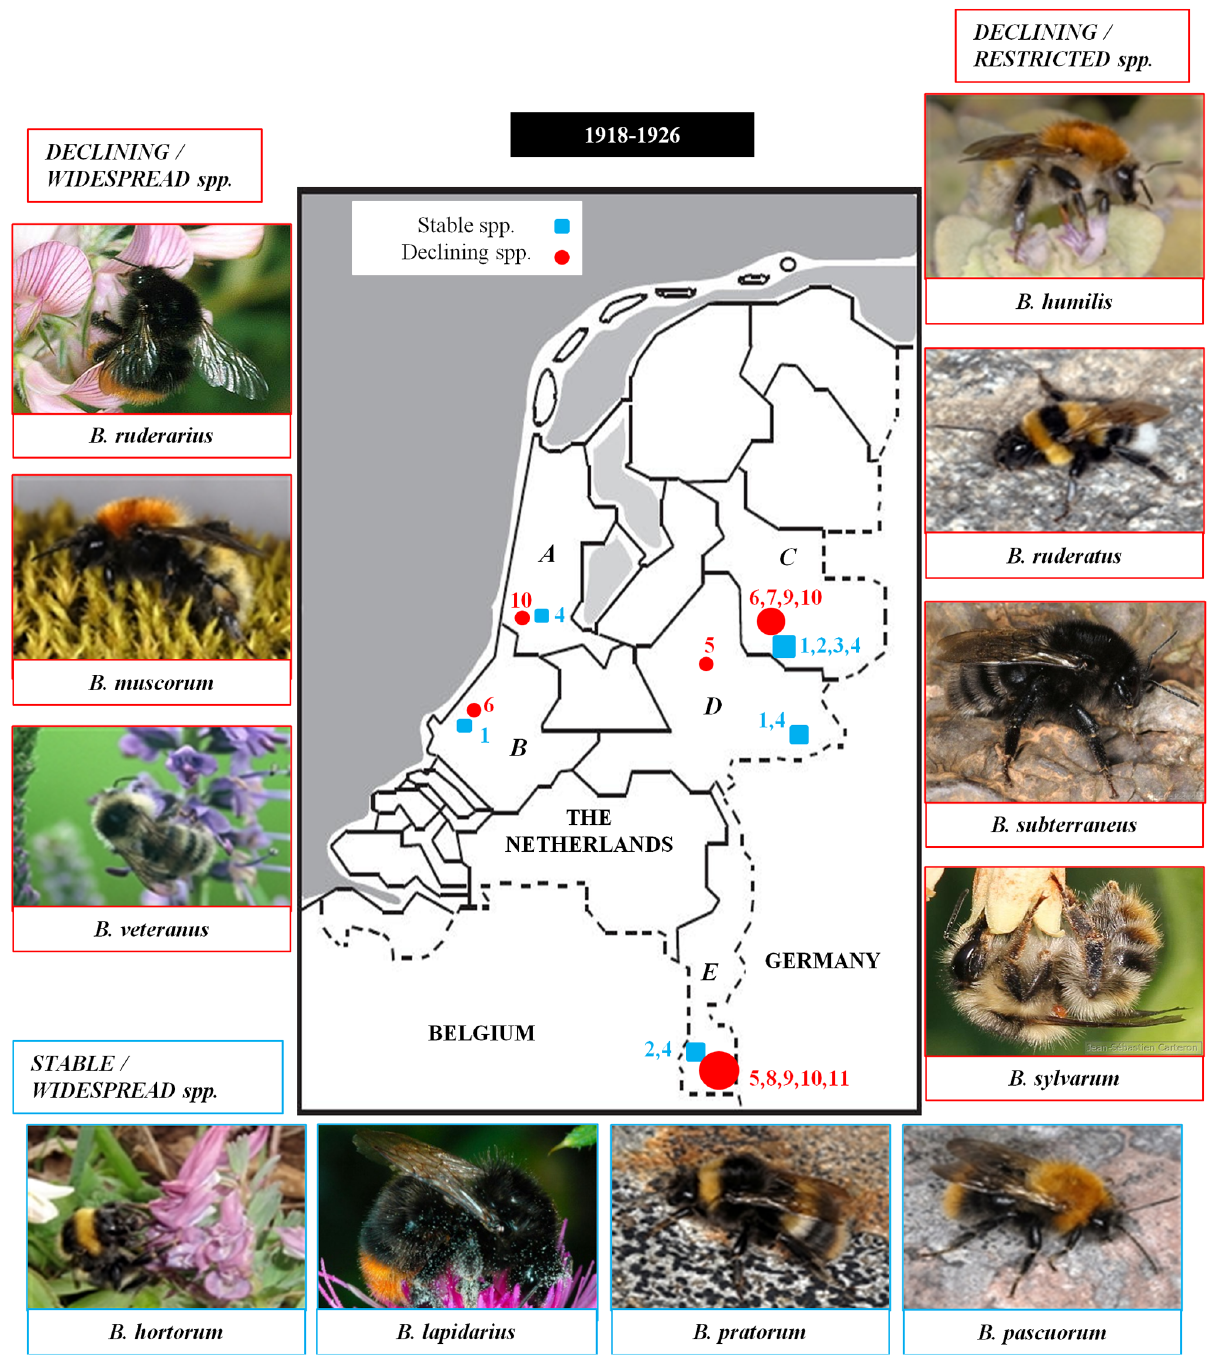
Fig 1. Distribution of the specimens of the declining and more stable Bombus spp. Specimens collected in the Netherlands between the years 1918 – 1926 before the recent bumblebee declines started (1950 – 1980), with a picture of each Bombus spp. used in the analysis. Species pictures from [56]. The letters refer to each sampling location: A = N-Holland, B = Z-Holland, C = Overrijssel, D = Gelderland and E = Limburg. Symbol size refers to the amount of species sampled at that location, while the numbers refer to which species. With for the stable and widespread species: 1 = B . hortorum , 2 = B . lapidarius , 3 = B . pratorum , 4 = B . pascuorum ; for the declining and restricted species: 5 = B . humilis , 6 = B . ruderatus , 7 = B . subterraneus , 8 = B . sylvarum , and for the declining and widespread species: 9 = B . muscorum , 10 = B . ruderarius , and 11 = B . veteranus .